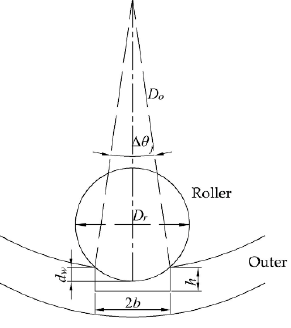
Figure 2. The interaction between the race and the defect.